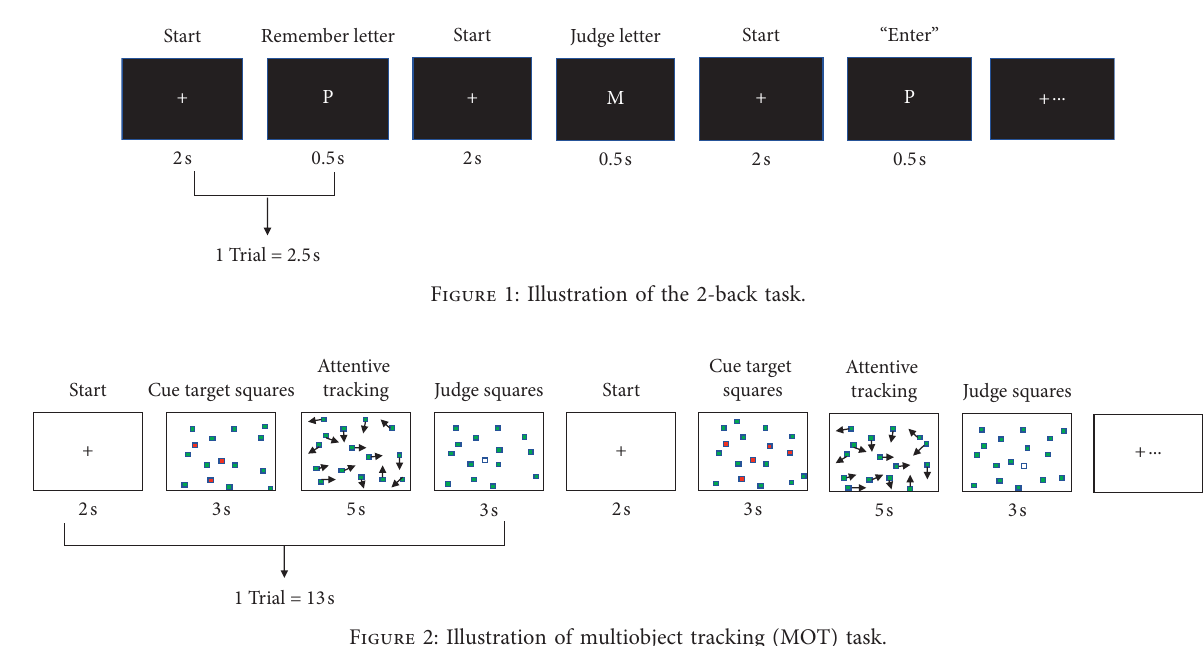
Figure 2: Illustration of multiobject tracking (MOT)